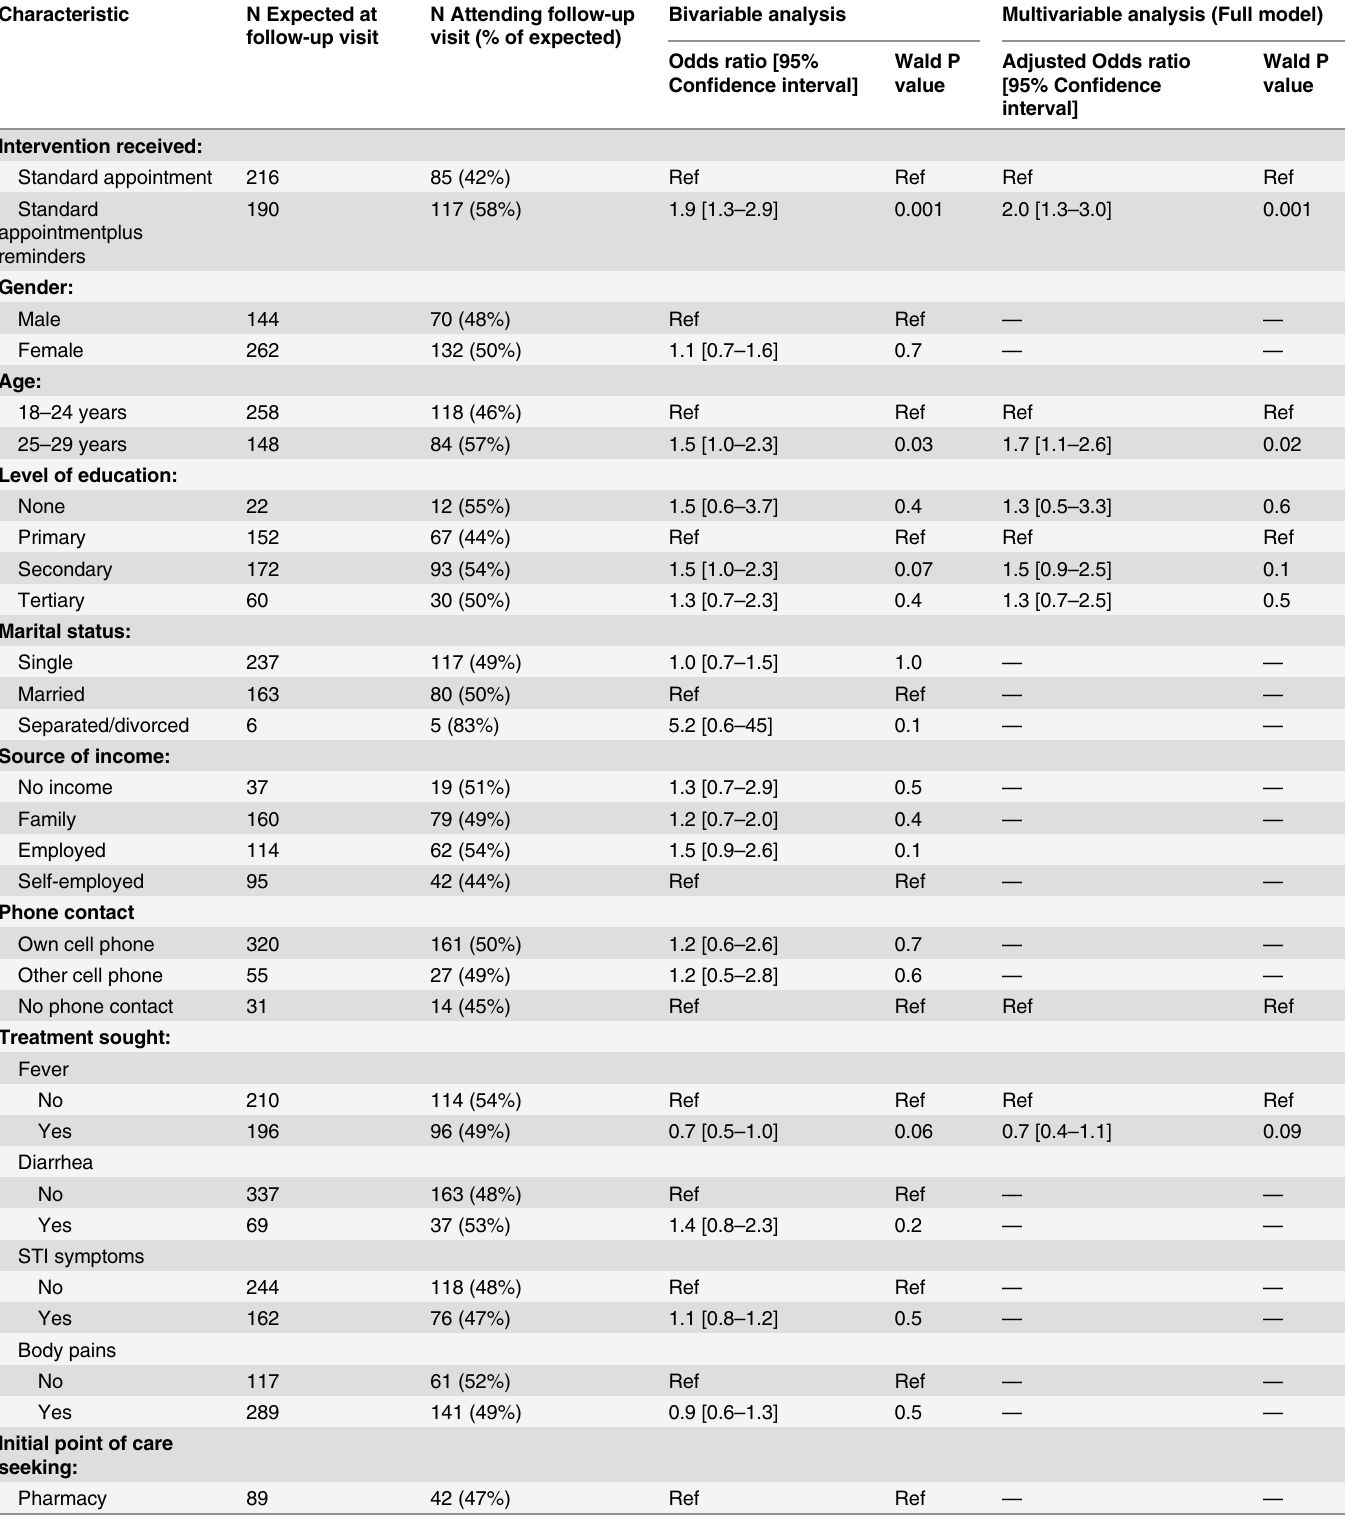
Table 2. Factors associated with visit attendance for repeat HIV testing.